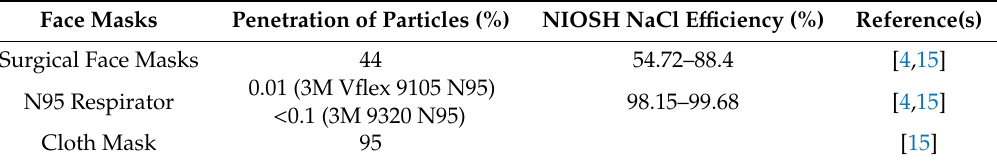
Table 1. Face masks filtration e ffi